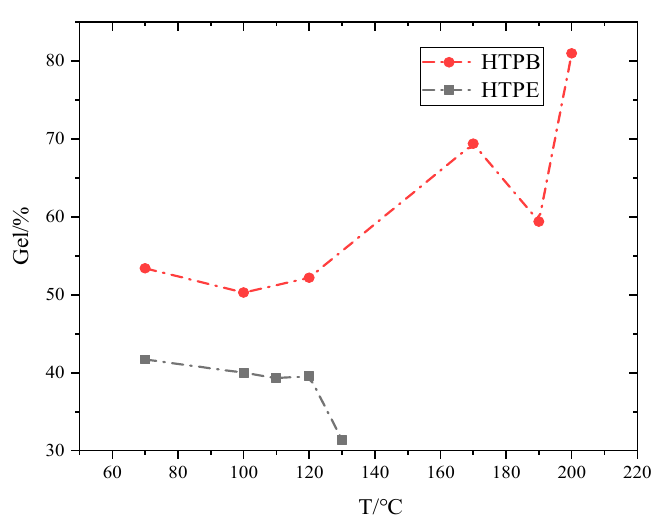
Figure 19. The relationship between gel fraction and temperature of HTPB and HTPE